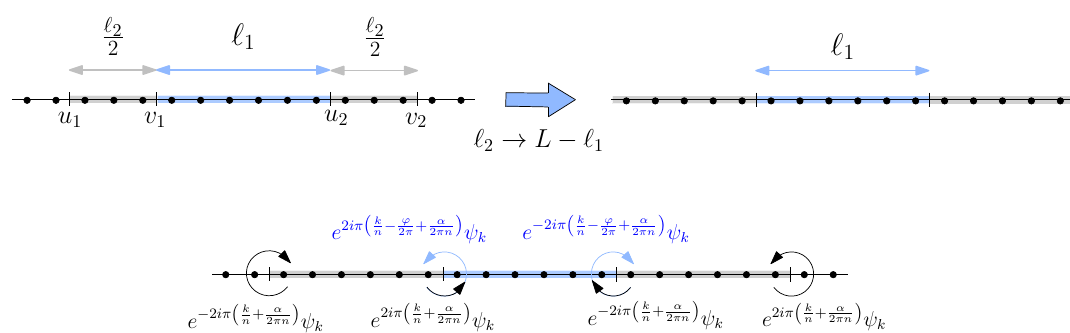
Figure 5: The tripartite geometry (left) of an interval of length (cid:96) embedded inside another subsystem of total length (cid:96) of total length L (right) is obtained taking the limit (cid:96) geometry. The bottom panel shows the phase taken by the field ψ branch point. The reduced density matrix corresponds to the union of the coloured regions, and the partial transpose is applied to the blue